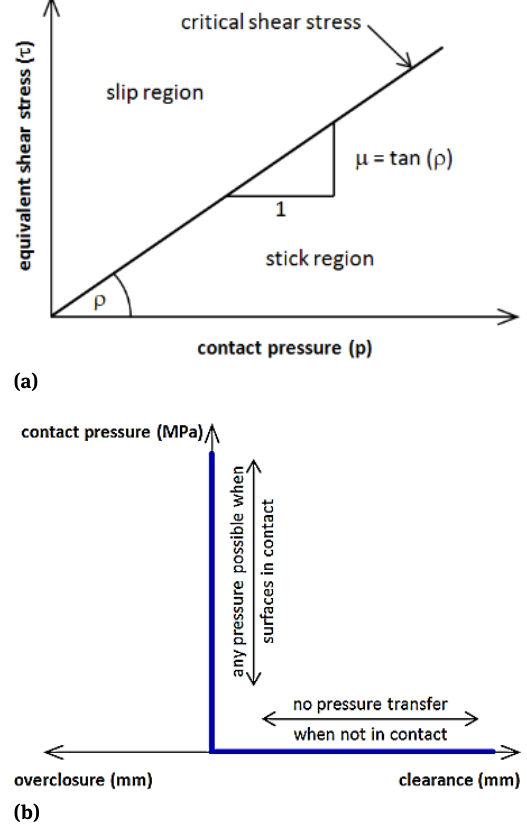
Figure 12: Coulomb friction law and vertical behavior between